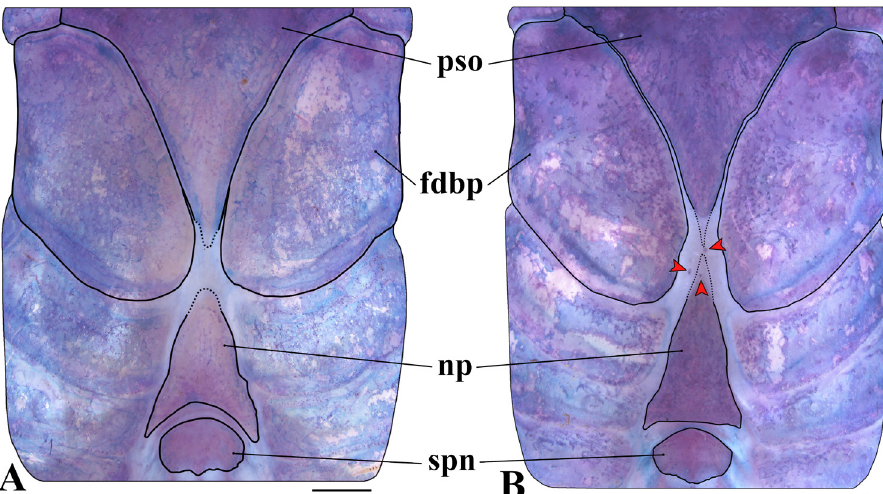
FIGURE 4 | Predorsal region of trunk in c&s paratypes of Corydoras maclurei , showing the variation in the distance between the posterior process of the parieto-supraoccipital and the nuchal plate, which ranges from ( A ) clearly separated from each other (CITL 430, 45.6 mm SL) to ( B ) separated but nearly contacting (CITL 430, 38.2 mm SL). Abbreviations: fdbp: first dorsolateral body plate, np: nuchal plate, pso: parieto-supraoccipital, spn: spinelet. Dotted lines indicate the limits of the tip of the posterior process of the parieto-supraoccipital and anterior tip of the nuchal plate. Red arrows indicate the small platelets between parieto-supraoccipital and nuchal plate. Scale bar = 1 mm.